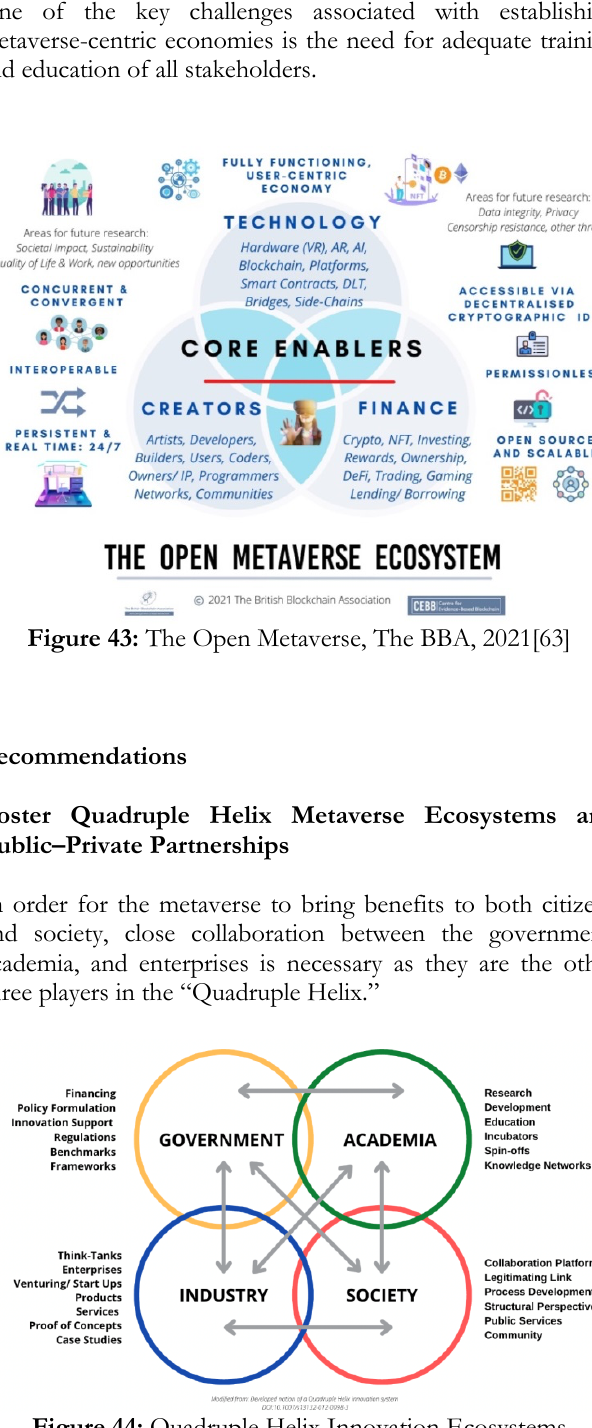
Figure 44: Quadruple Helix Innovation